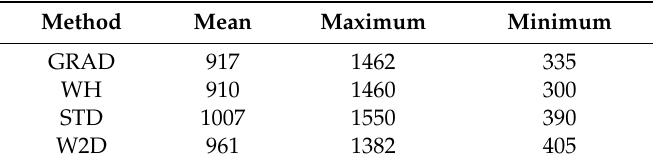
Table 5. Comparison of ML layer height (m) estimated by di ff erent methods for winter sunny days of 2013.